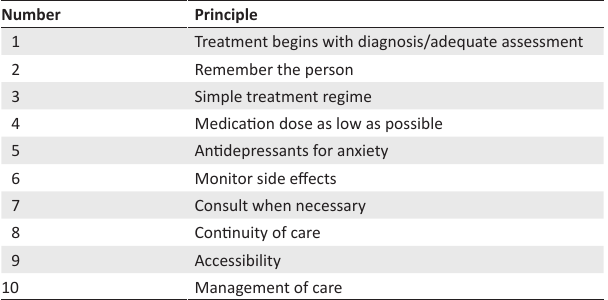
TABLE 1: Principles that were evaluated in the study. Number